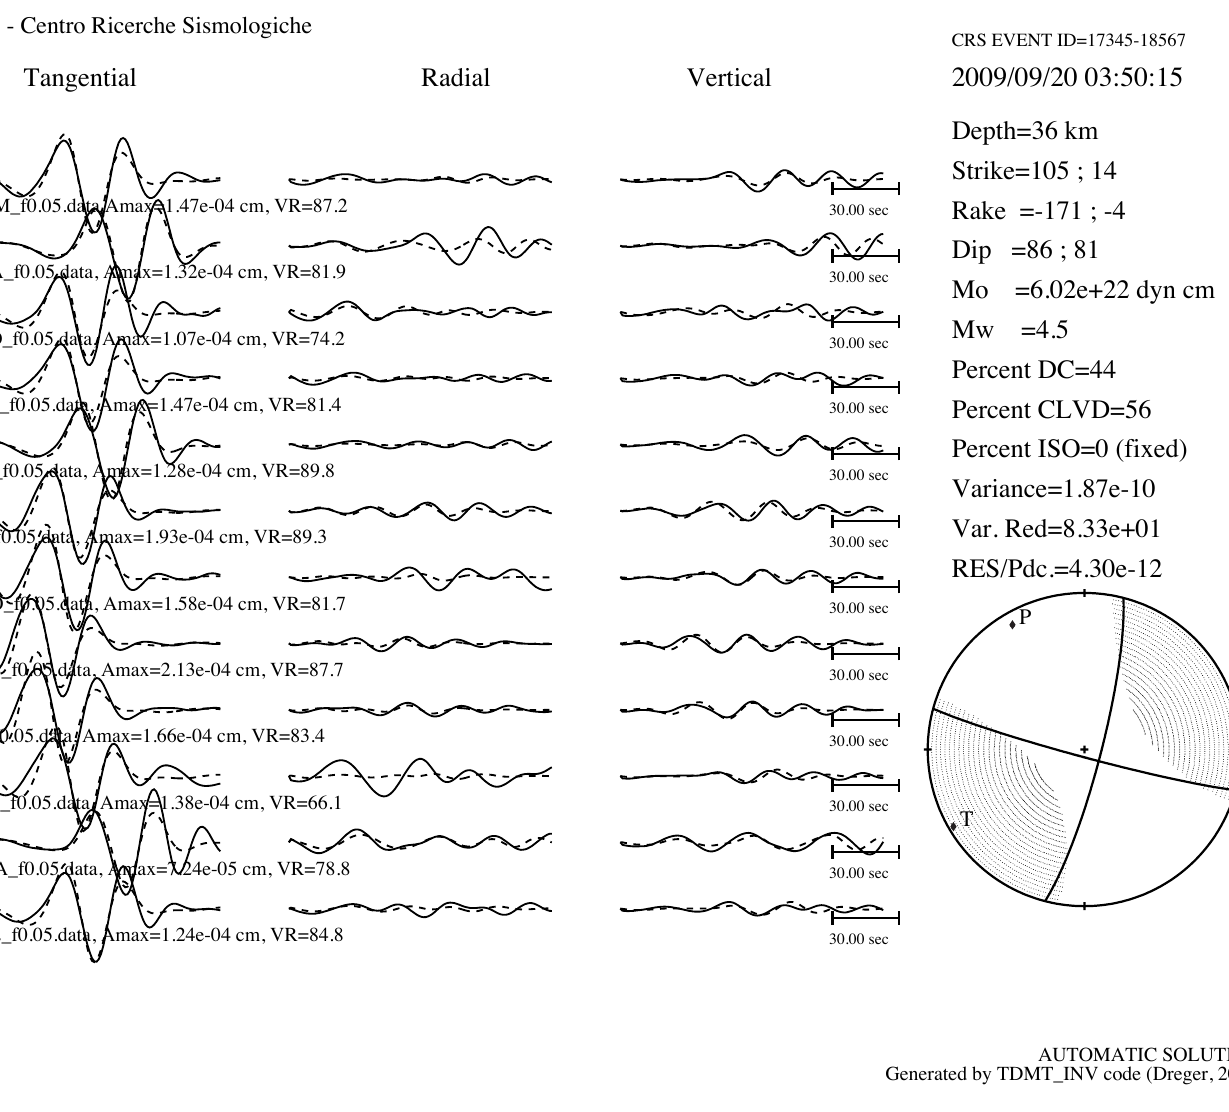
Figure 7. Example of a moment tensor retrieved for a Mw = 4.5 earthquake using data collected at the OGS-CRS. Left: waveform fit between real (solid line) and synthetics (dashed line). For each trace the code of the station is used, and the maximum amplitude (Amax) in cm and the variance reduction (VR) are reported. Right: the best solution, below the CRS event ID and the date, is given in terms of depth (km), strike, rake, dip, seismic moment (M0), moment magnitude (Mw), percent of double couple (DC), compensated vector linear dipole (CLVD), isotropic (ISO) component, variance, variance reduction (Var. Red) and the variance divided by the DC percentage (RES/PDC). Finally, the plot of the fault plane solution is given (bottom